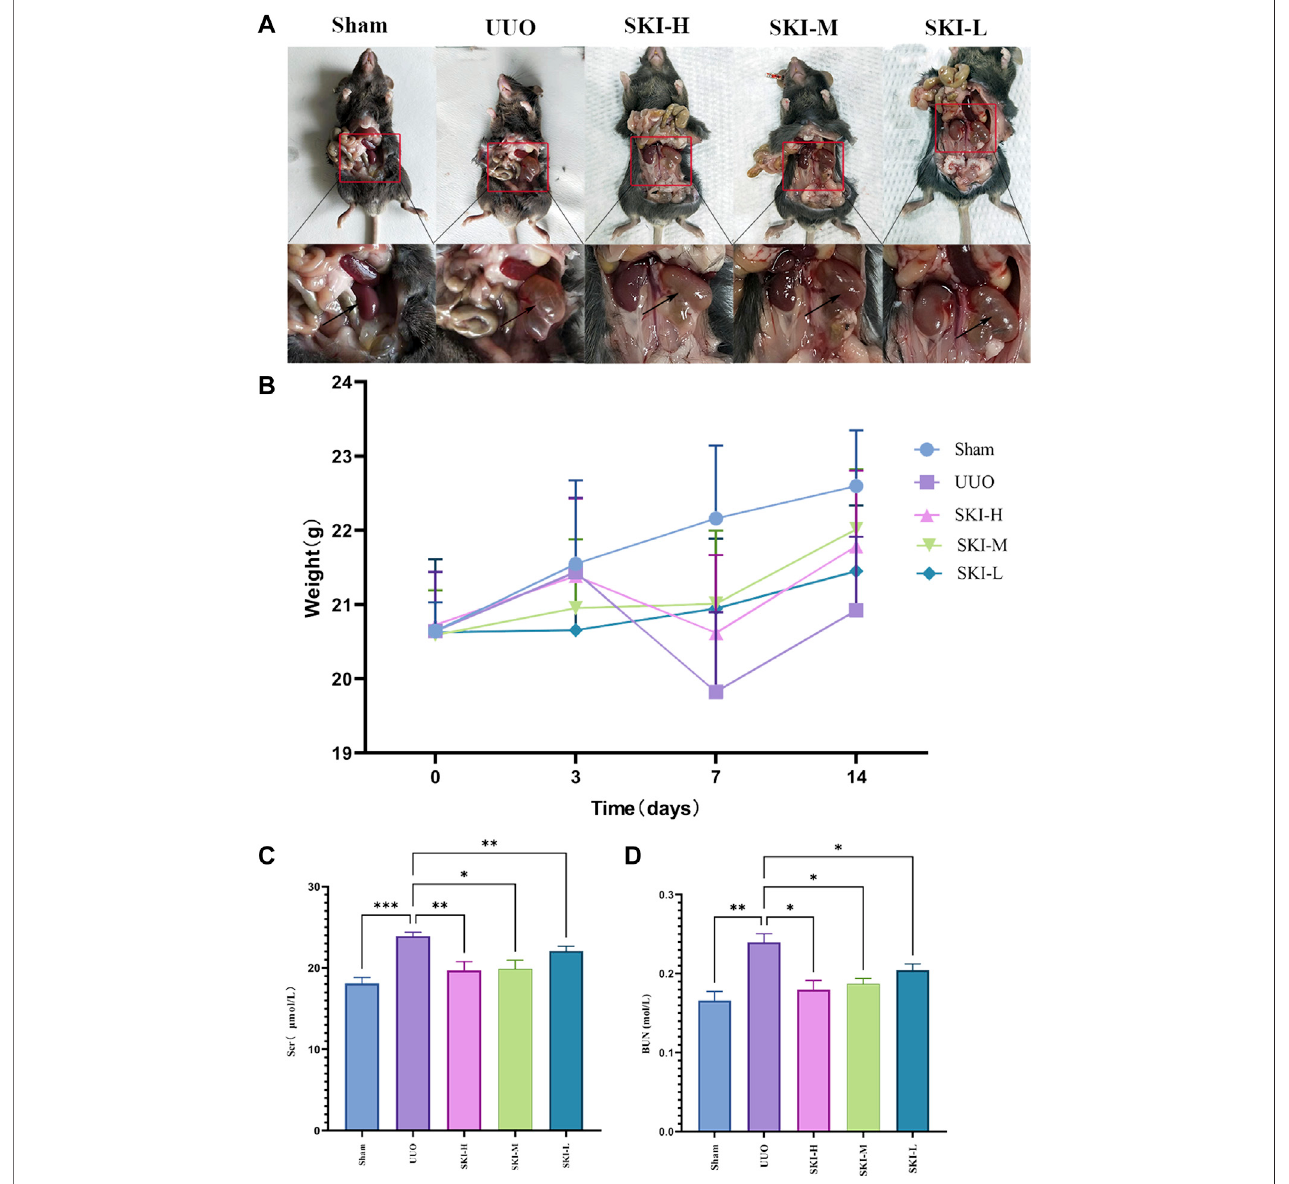
FIGURE2| Effects ofShenkanginjection onbodyweight,Scr,and BUNofUUOmodel mice. (A) Renal effusion ontheligationside. (B) Changesinbodyweightof mice. (C) and (D) Changes of Scr and BUN in mice. Compared with the model group, * p < 0.05 and ** p < 0.01.